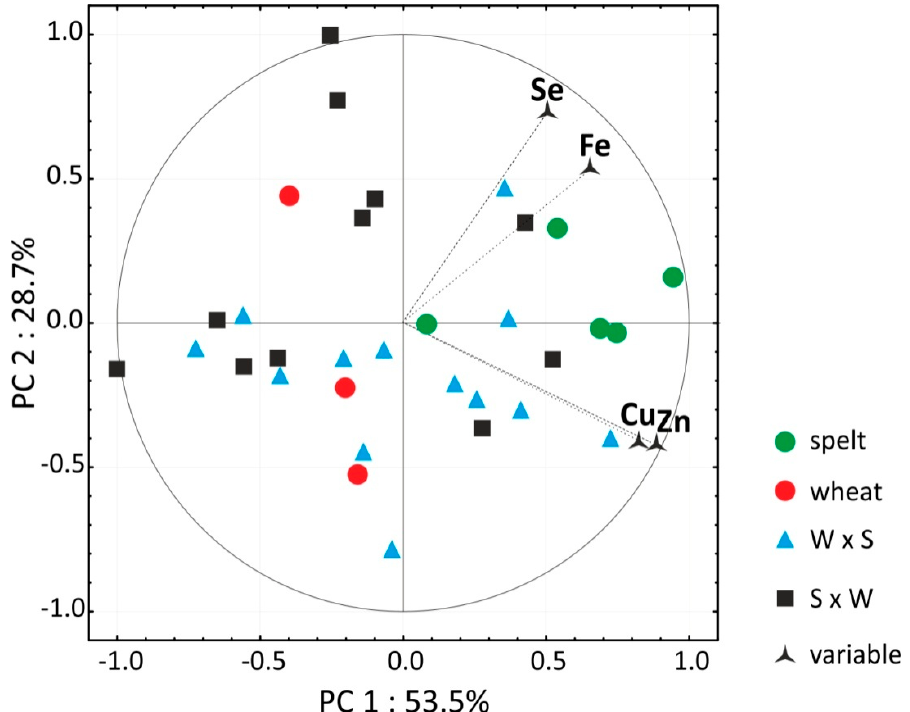
Figure 3. Biplot presenting PCA results for the contents of four desirable micro elements in the grain of the studied cereals. W × S—wheat × spelt; S × W—spelt ×